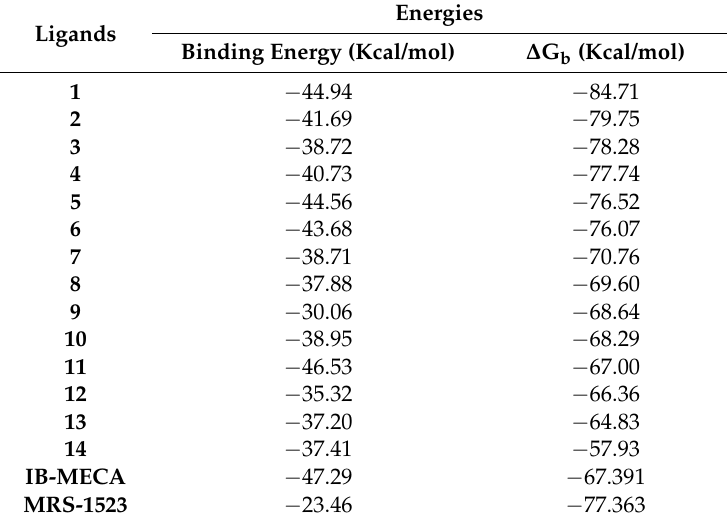
Table 1. Binding energies and free energies ( ∆ G b ) for the fourteen compounds that were post-filtered according to their interactions with the active site of the A 3 receptor.